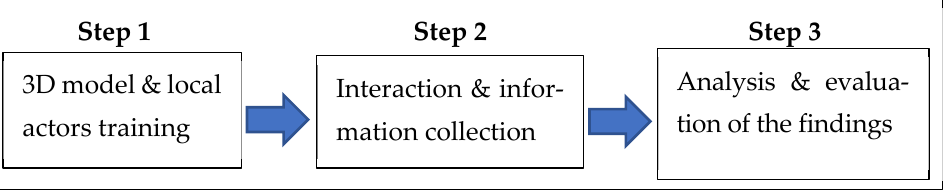
Figure 3. The workflow diagram of the 3D participatory process.